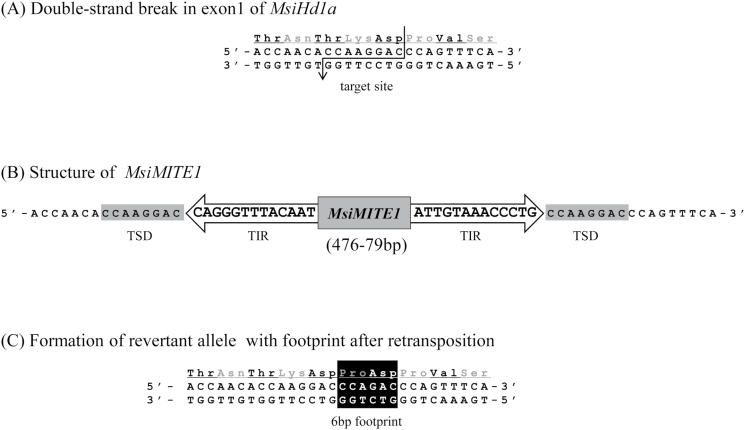
The structure of MsiMITE1 and a schematic diagram of its insertion and retransposition. (A) A target site before insertion of MsiMITE1. (B) Miniature inverted transposable element (MITE)-like sequences are recognized by terminal inverted repeats (TIRs) and target site duplications (TSDs). (C) Revertant alleles contain a 6bp footprint which encodes two additional amino acids (proline and aspartic acid) at the insertion-retransposition site of MsiMITE1.